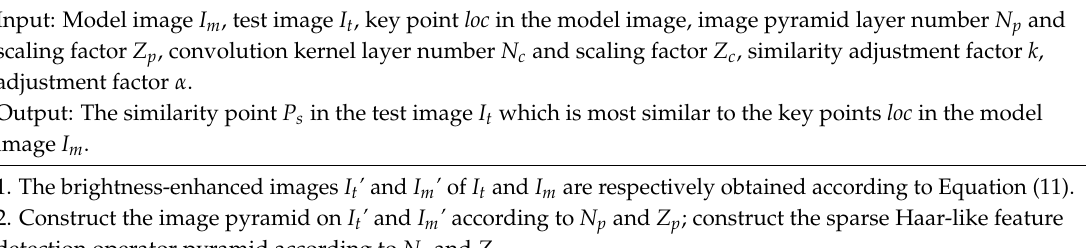
Algorithm 1 : Flow of feature-matching algorithm based on sparse Haar-like feature and similarity calculation.